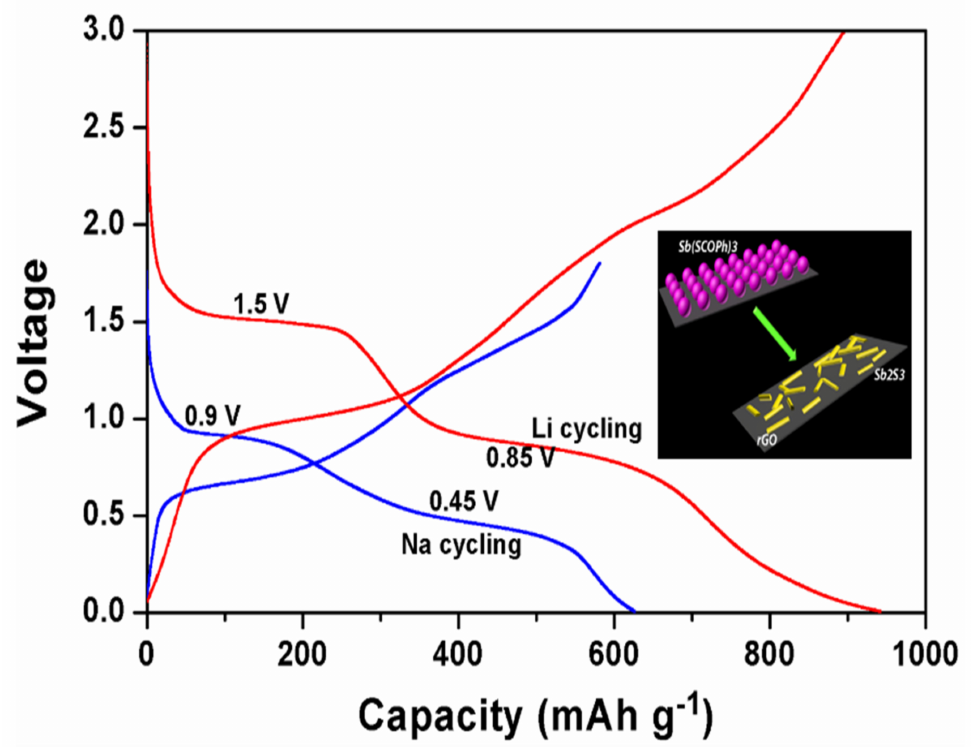
Figure 10. Charge–discharge studies of Rgo/Sb 2 S 3 nanocomposites with lithium and sodium anodes (adapted with permission from [162]. ACS,